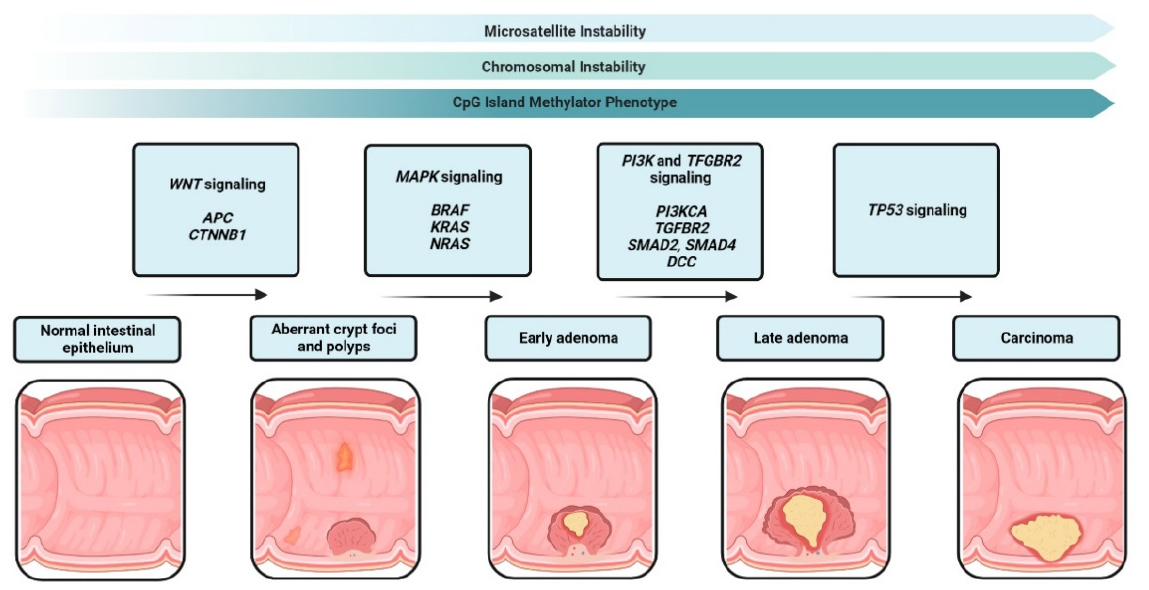
Figure 1. Adenoma-carcinoma sequence from healthy epithelium to carcinoma in situ. Carcinogenesis progresses through the accumulation of several mutations in oncogenes such as BRAF, KRAS or HRAS and tumor suppressor genes such as APC, SMAD2 or TP53.